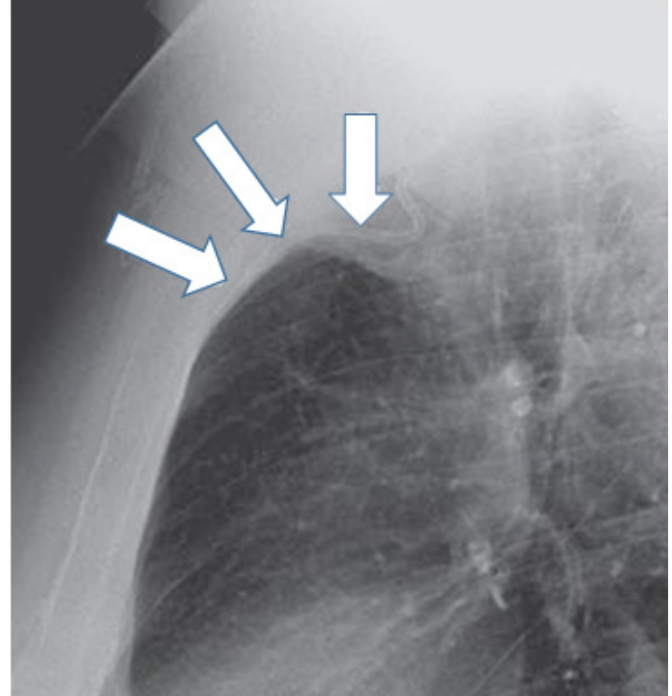
Figure 6. Lateral chest radiograph of patient in Figure 5 show- ing catheter (arrows) malposition coursing anteriorly along right internal mammary